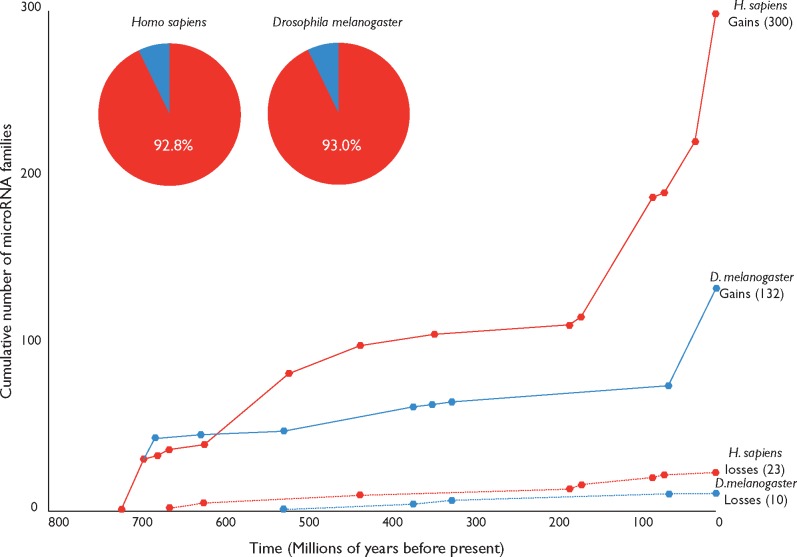
—Cumulative numbers of gains and losses of miRNA families in the lineages leading to the two most completely sampled taxa (Homo and Drosophila) over the past 720 Myr based on our curated data set.